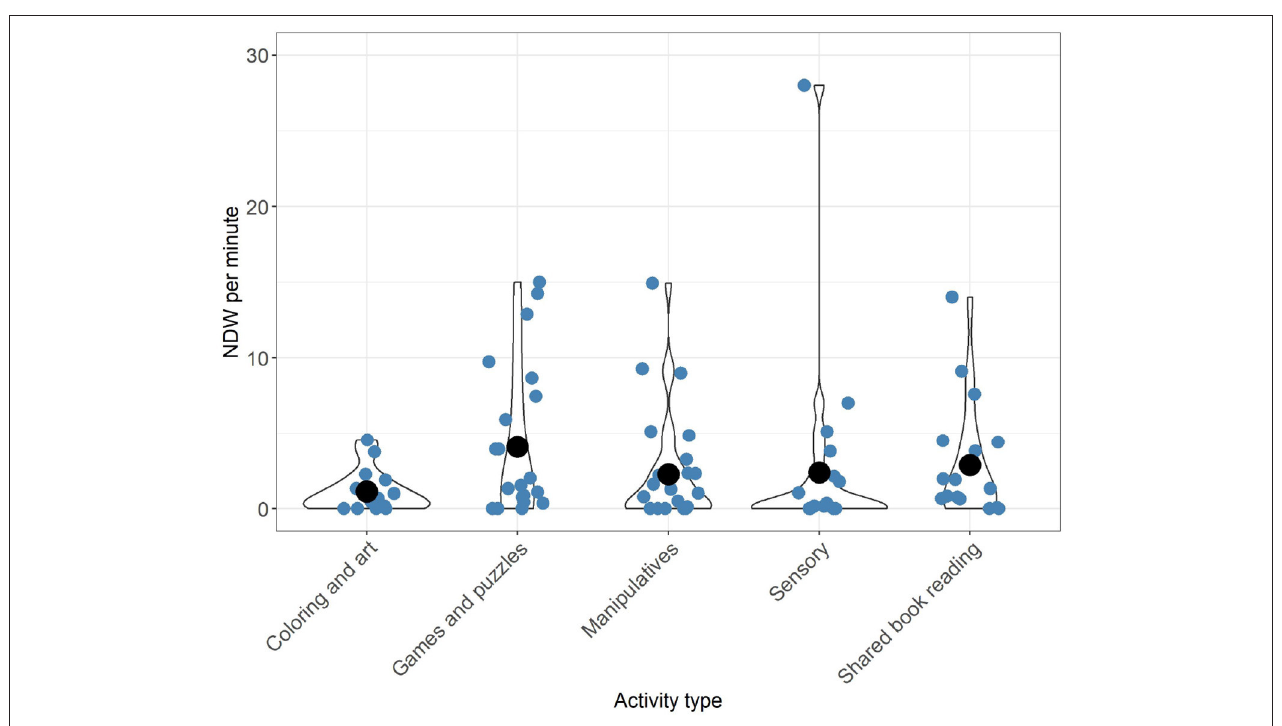
FIGURE 3 | Number of different words (NDW) per minute by activity